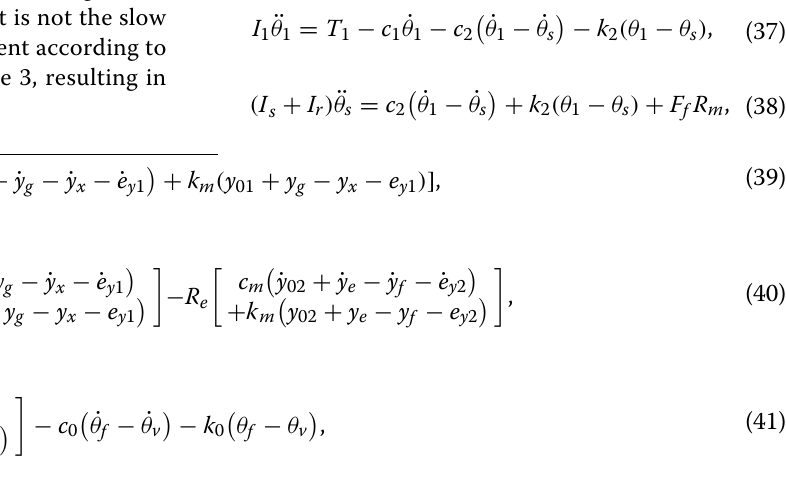
Stage 5 : After the speed is eliminated, the contact between the sleeve and the teeth surface of the friction cone produces a speed difference. The generated speed difference is used to complete the teeth advancement. The state of PCFRS at this stage is shown in Figure 17.